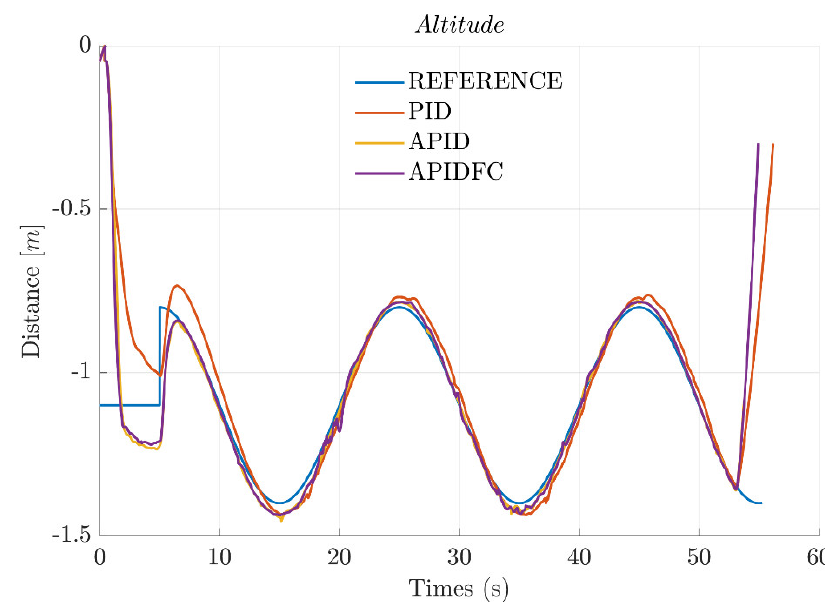
Figure 16. Altitude response to following the sine wave references.